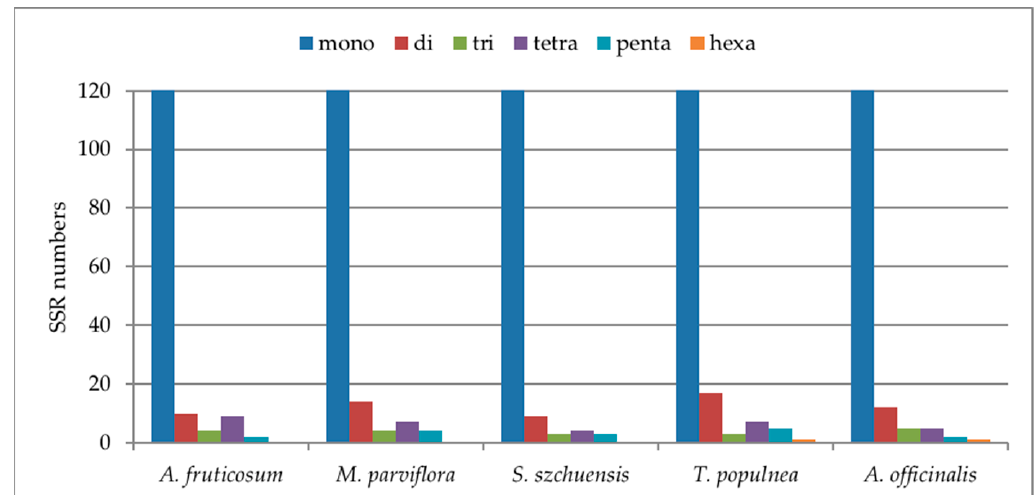
Figure 6. Number of different SSR types in the chloroplast genome of five Malvaceae.